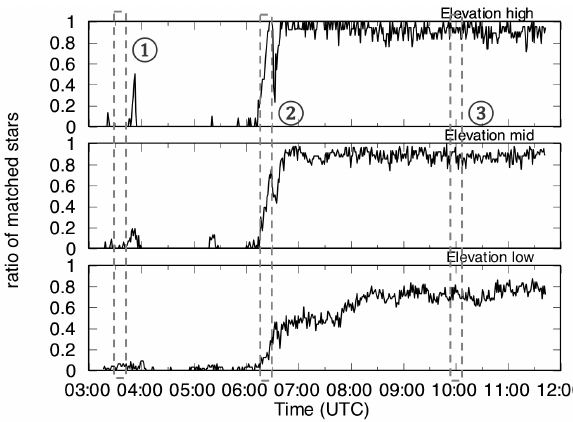
Figure 9: Time variation of ratio of matched stars in a day. (Bottom(Elevation low) : 0 (cid:20) Elevation angle (cid:20) 30, middle(Elevation mid) : 30 < Elevation angle (cid:20) 60, Top(Elevation high) : 60 < Elevation angle (cid:20) 90)